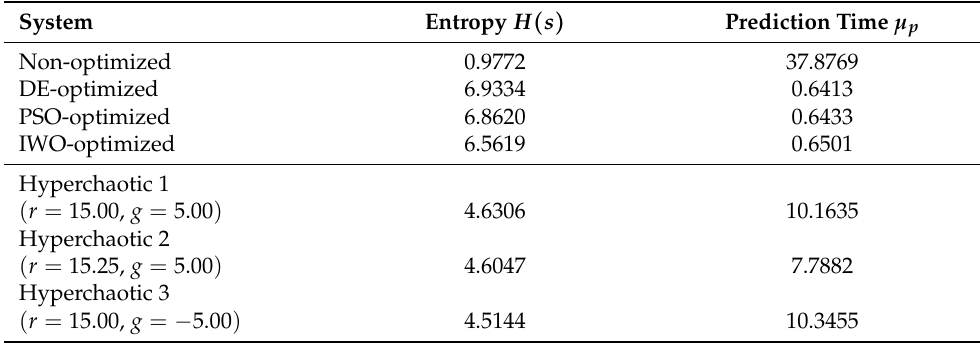
Table 3. Information entropies and prediction times of the non-optimized and optimized chaotic systems, and the best three hyperchaotic states of the new hyperchaotic system. System Entropy H ( s